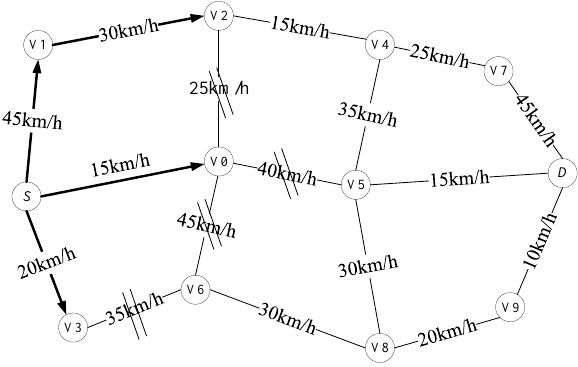
Figure 9. Prune strategy with SGHS* algorithm.